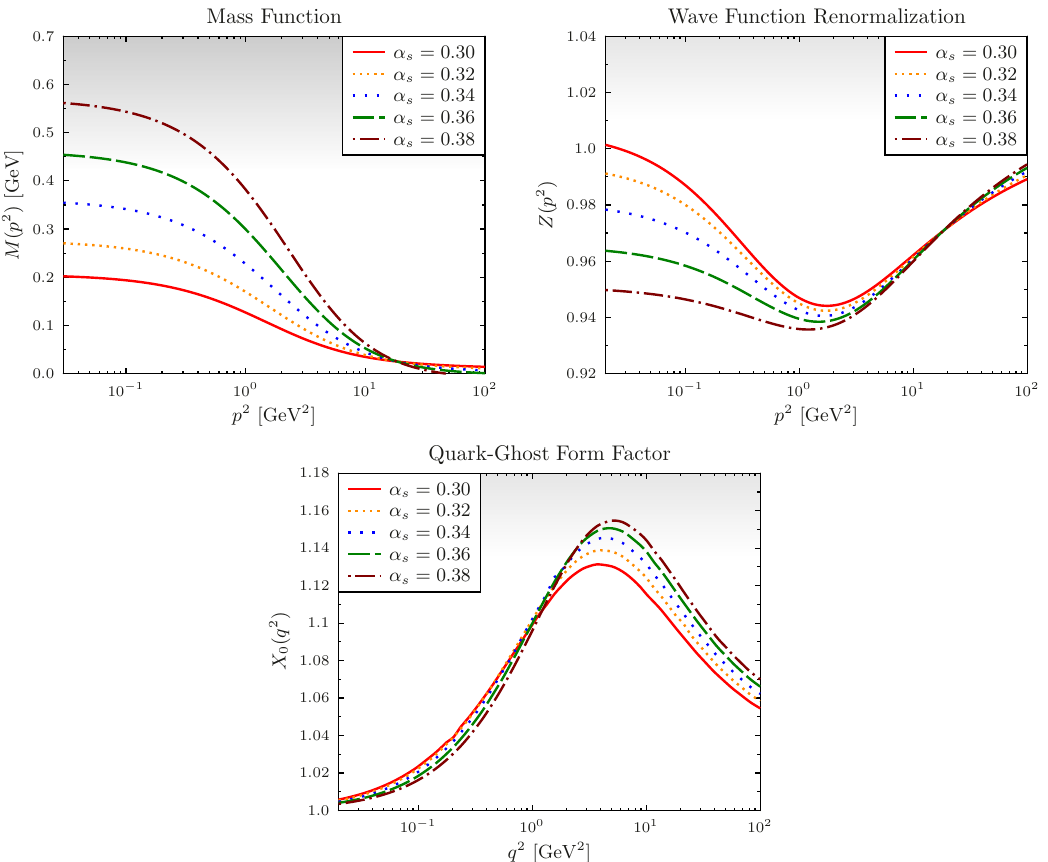
Figure 5 . Functional dependence of M ( p 2 ) , Z ( p 2 ) and X 0 ( q 2 ) on the strong coupling α s . The DSE (2.15) is solved with the vertex Γ µ ( k, p ) = Γ L factors in eqs. (2.44)–(2.55); and with the gluon and ghost propagators of set III [30]. The current- quark mass is m (4 . 3 GeV) = 25